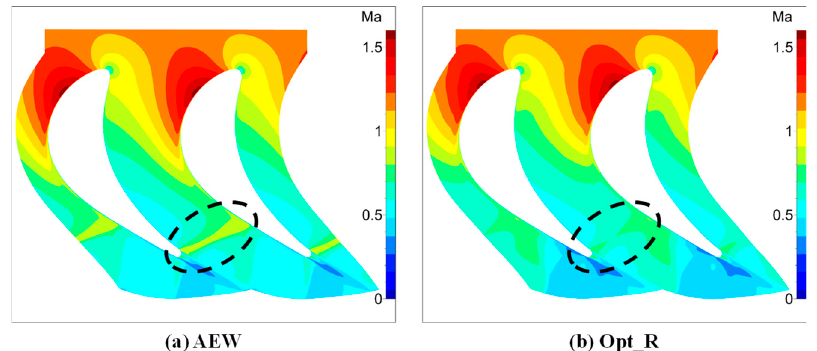
Figure 13. ( a , b ) Spanwise distribution of mass-averaged quantities.